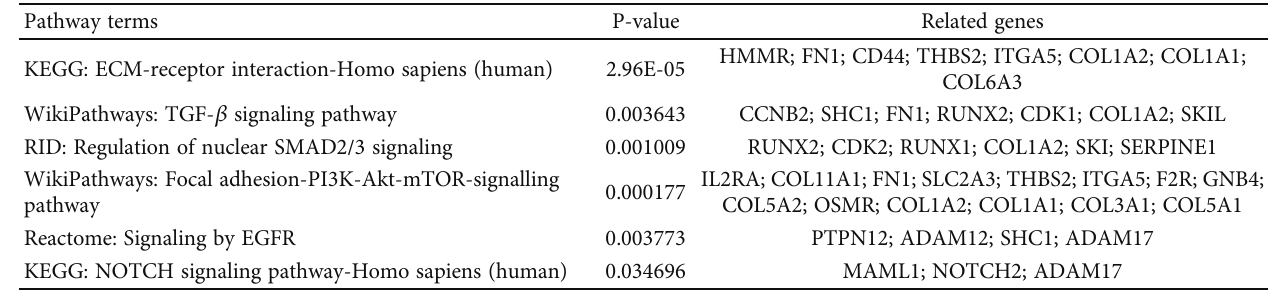
Table 5: KEGG analysis of FXYD2 in the TCGA